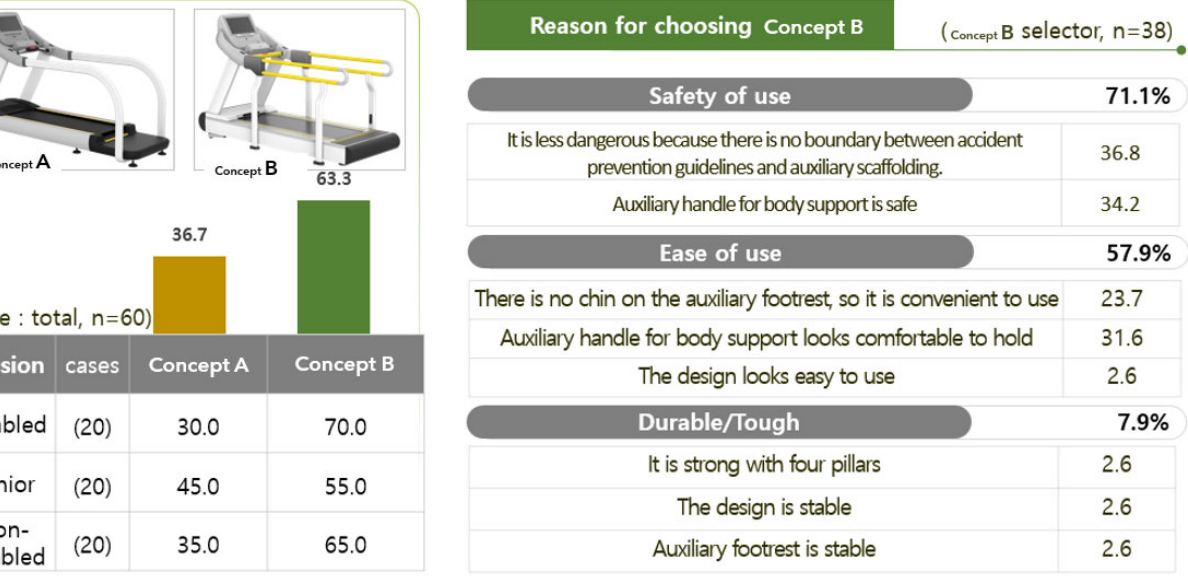
Figure 12. Results of the preference property evaluation of the treadmill product design.